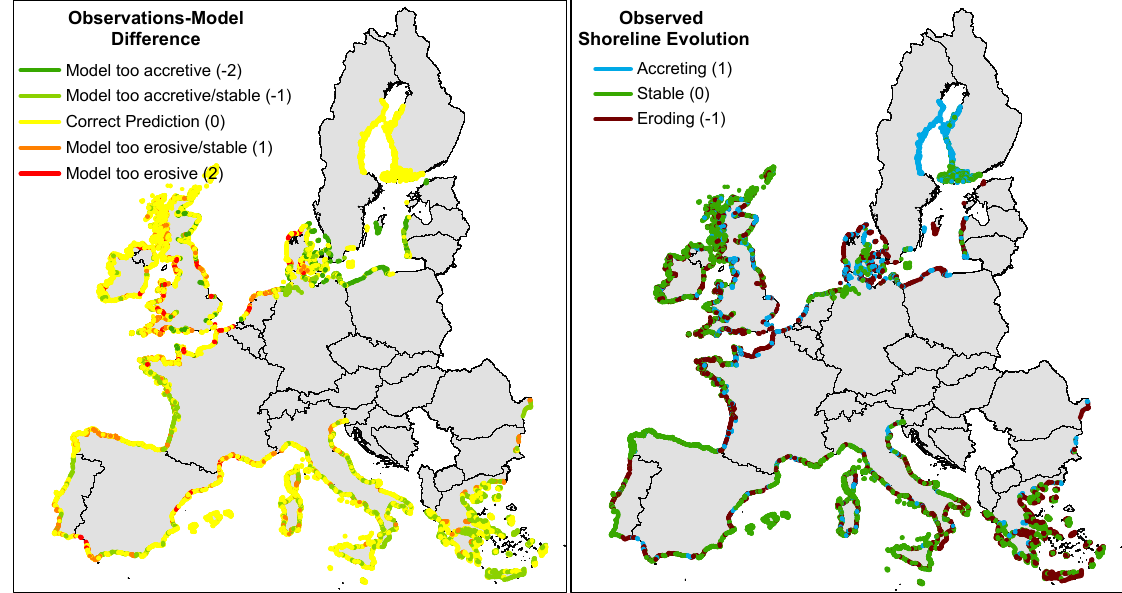
Fig. 3. Spatial distribution of (left) the difference between the Bayesian Network model “prediction” and the observations of coastal shoreline evolution, and (right) the observed shoreline